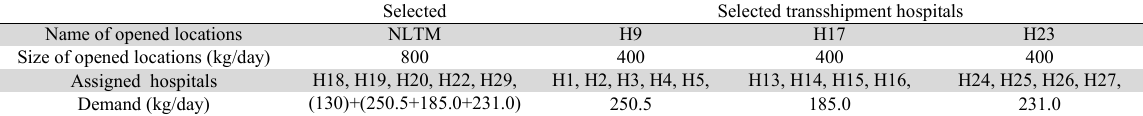
The solutions of the proposed holistic approach